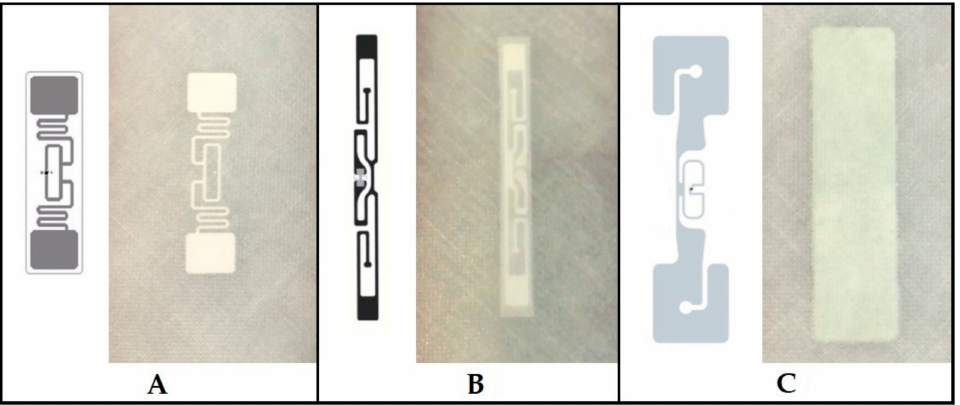
Figure 7. Individual tested RFID tags models: ( A ) AZ9662 H3, ( B ) AD-226iM, ( C ) DogBone and their implementation in laminate structures; Based on